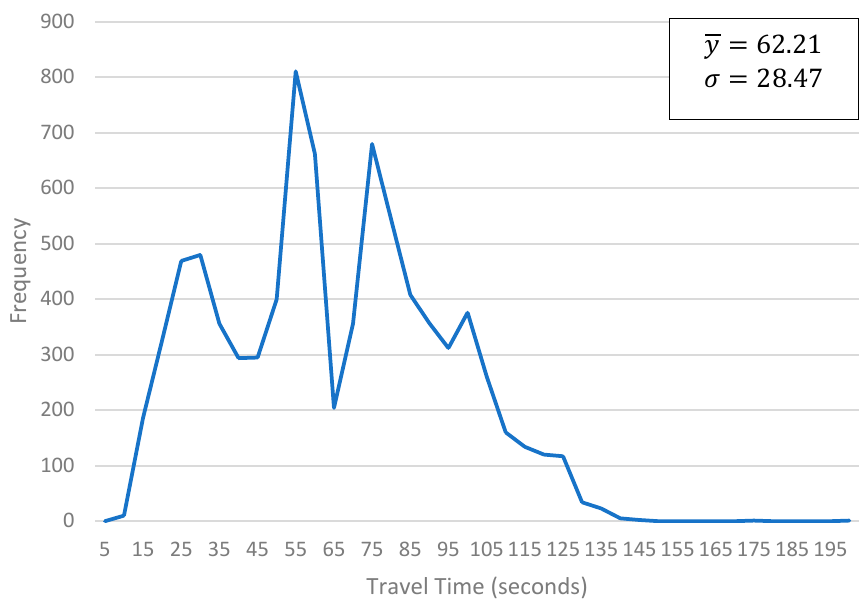
Figure 8. Histogram for initial_values dataset, mean and standard deviation.